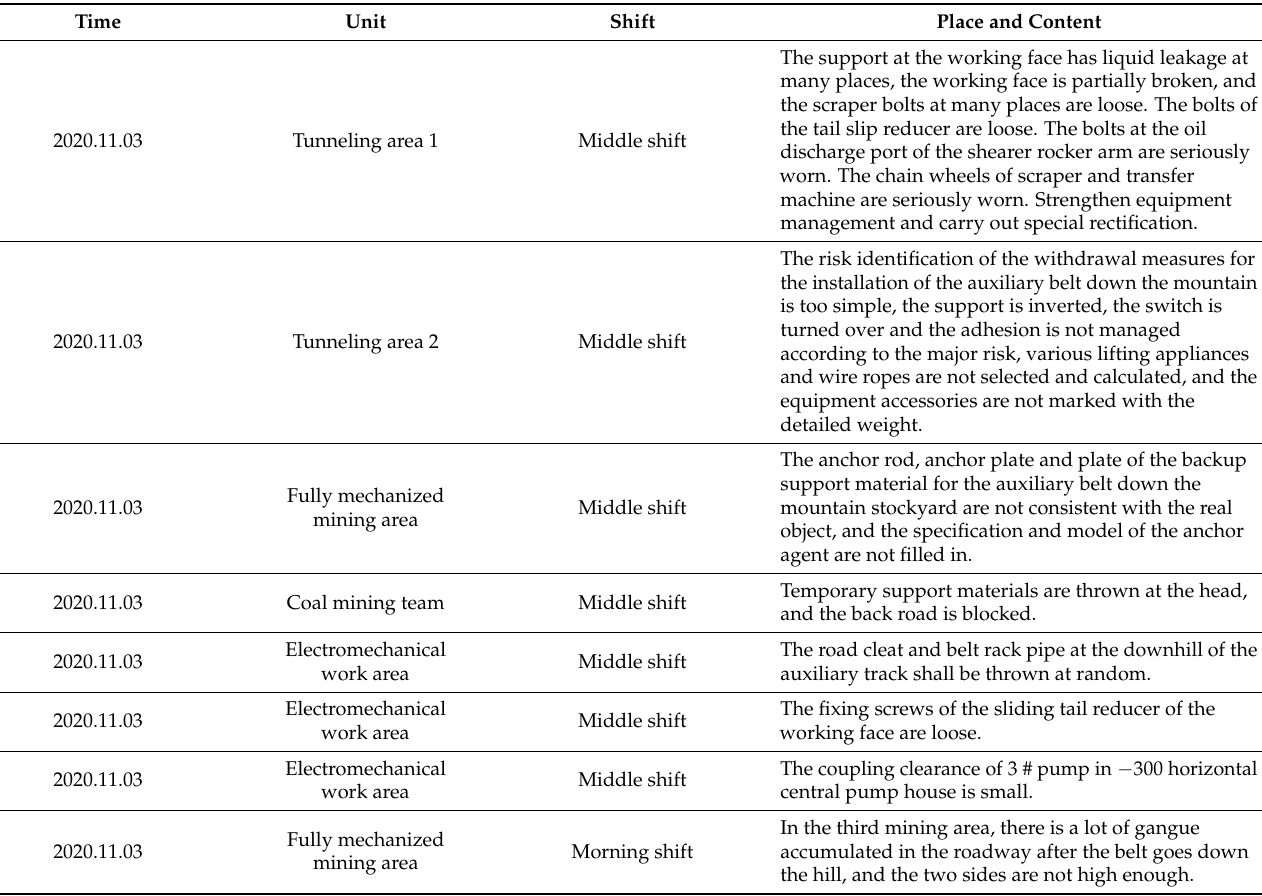
Table A1. Raw data of hidden danger information in Luxi coal mine.